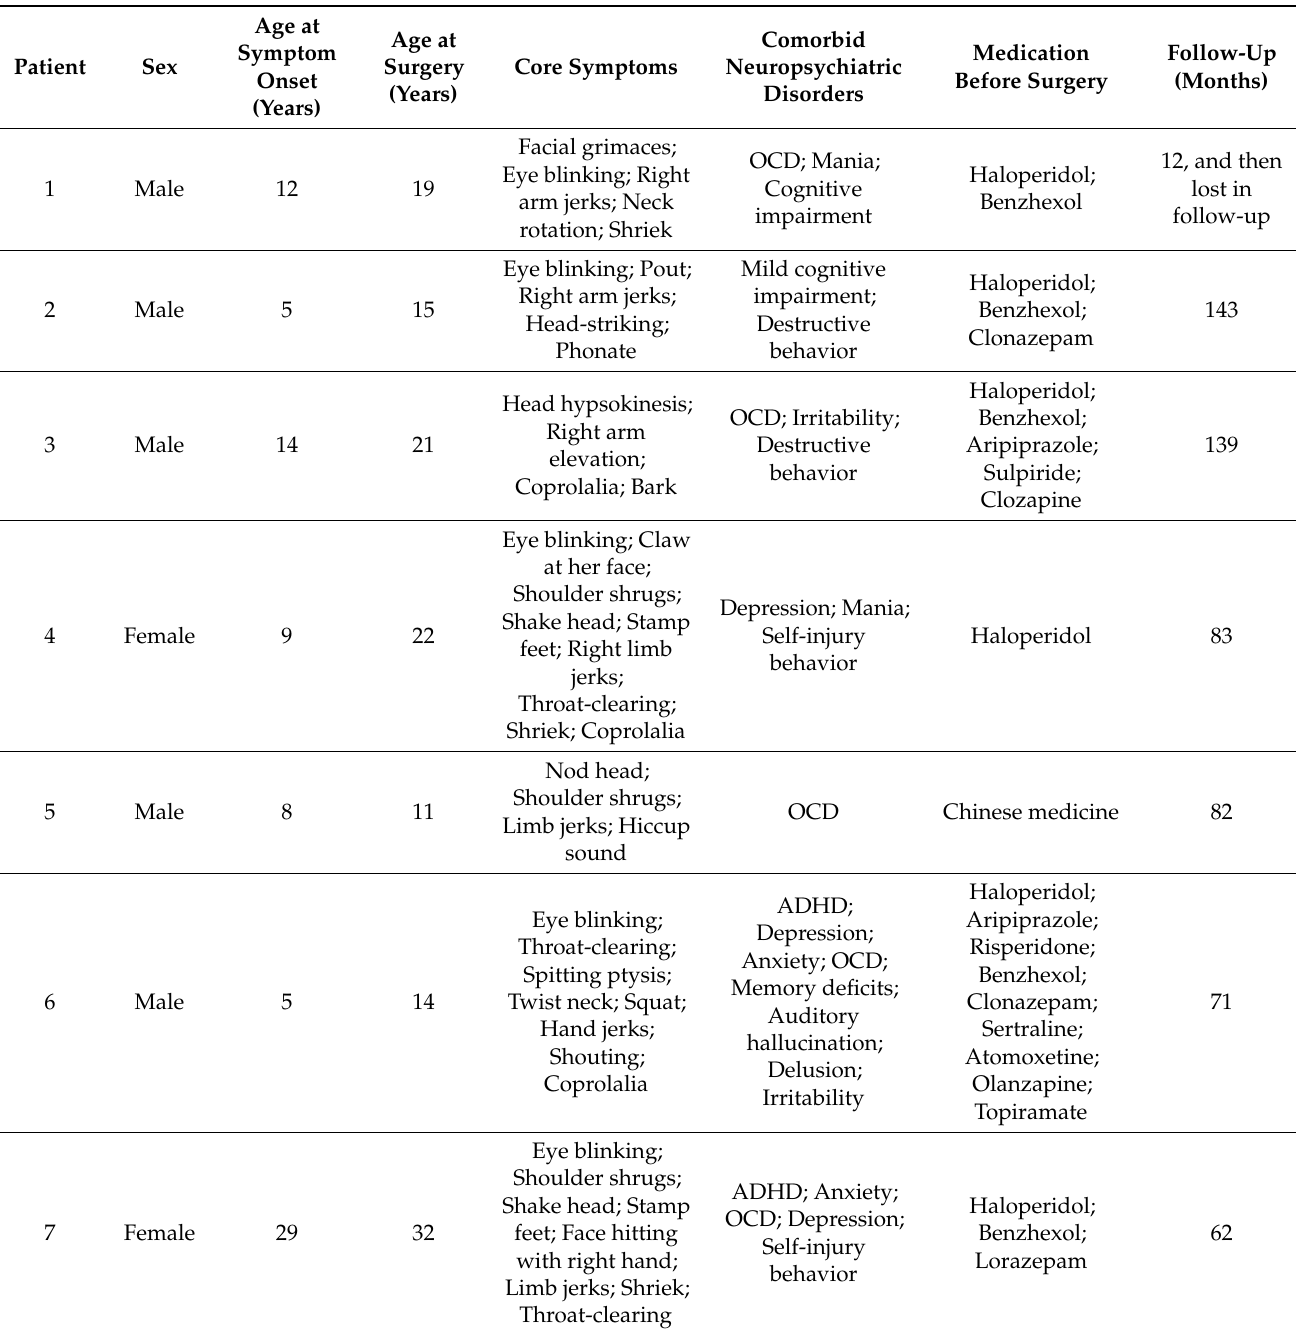
Table 1. Baseline clinical characteristics of thirteen patients with